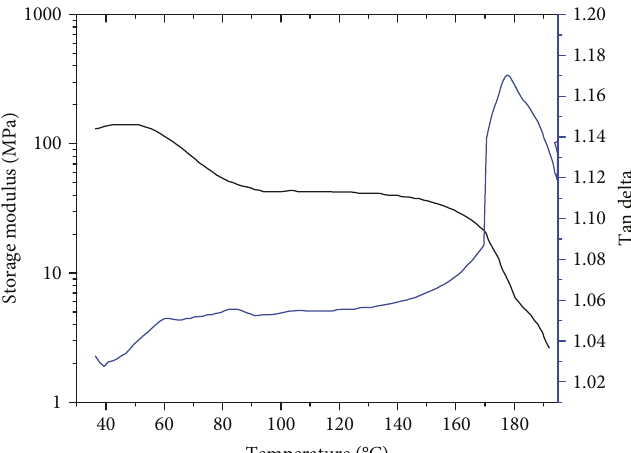
Figure 2: DMA from the xerogel HEC/PAAm.